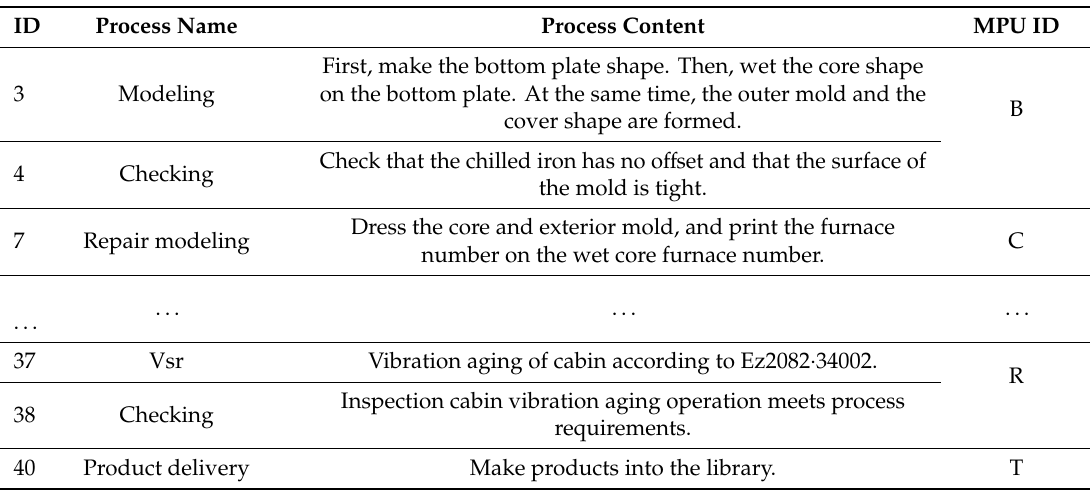
Table 4. The part of the manufacturing process by EAB and MPU.